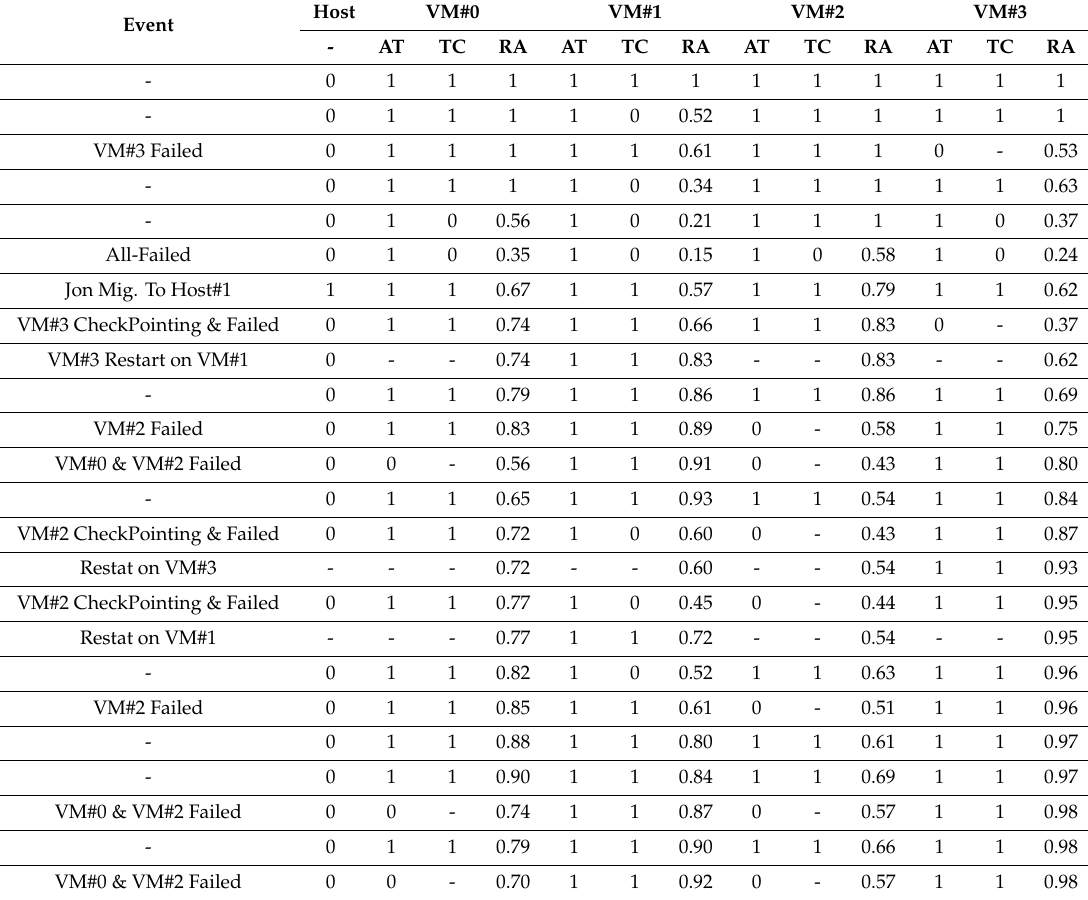
Table 3. Results of Simulating AFTRC in